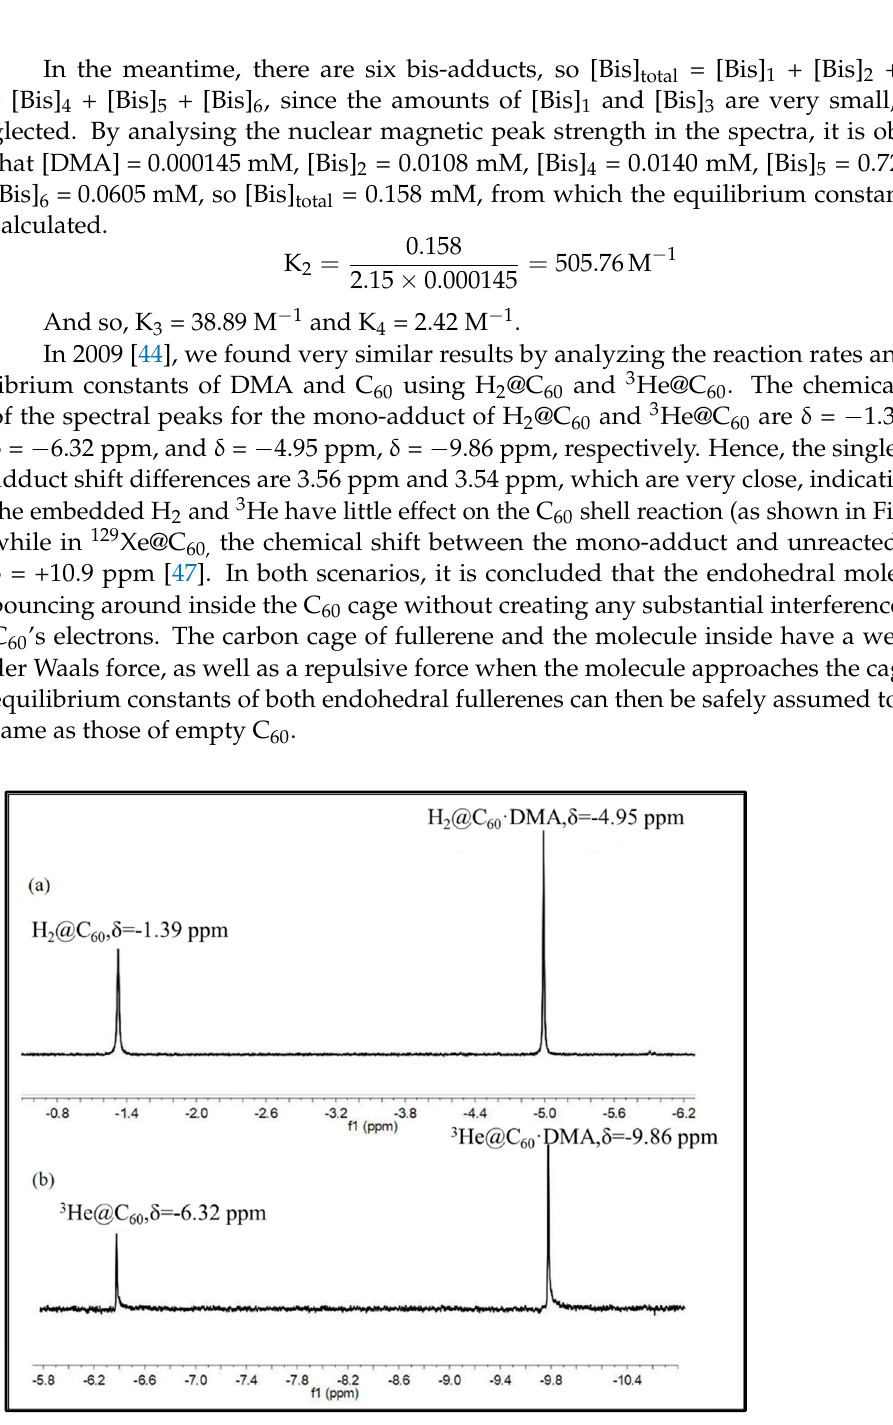
Figure 5. ( a ) 3 He NMR spectrum of 3 He@C 60 and mono-adduct with DMA; ( b ) 1 H NMR spectrum